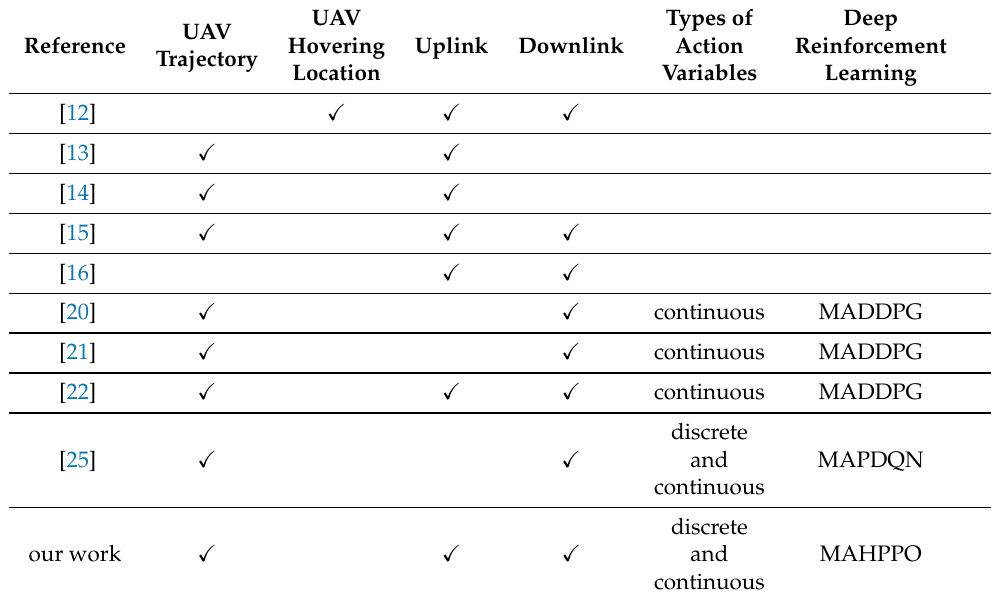
Table 1. Comparison between our work and the related